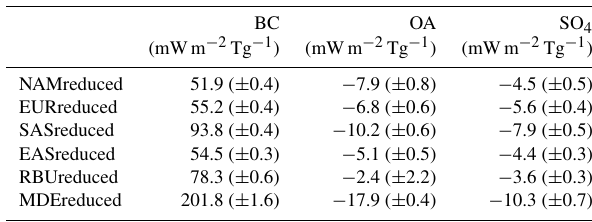
Table 3. Globally averaged radiative forcing from the six main ex- periments, weighed by the emission change for the given source re- gion. Relative 1 standard deviations (representing multi-model vari- ation) are given in